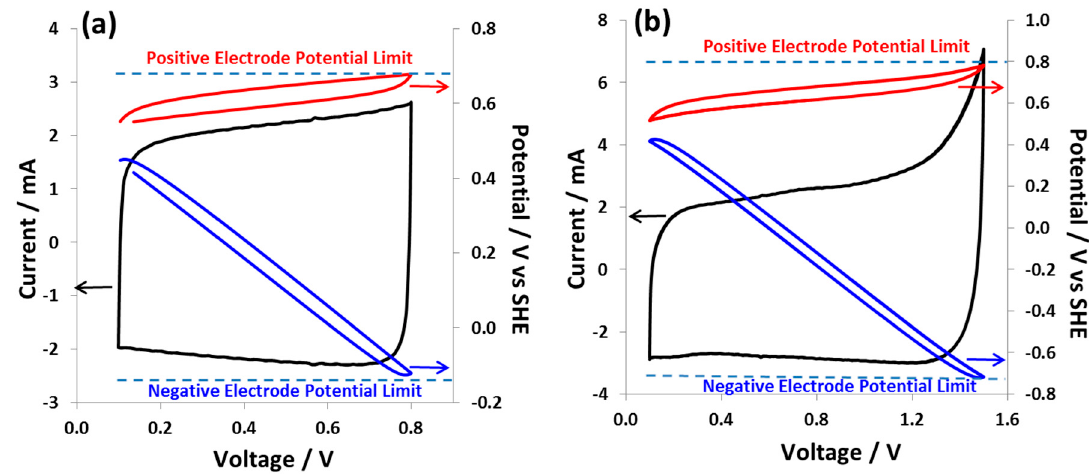
Figure 1. Cyclic voltammograms at v = 2 mV s − 1 and voltage ( a ) 0.1 V to 0.8 V and ( b ) 0.1 V to 1.5 V of carbon/carbon hybrid cell 1. The upper red curve and lower blue curve demonstrate respectively the potential excursion of a positive and negative electrode during cyclic voltammetry.